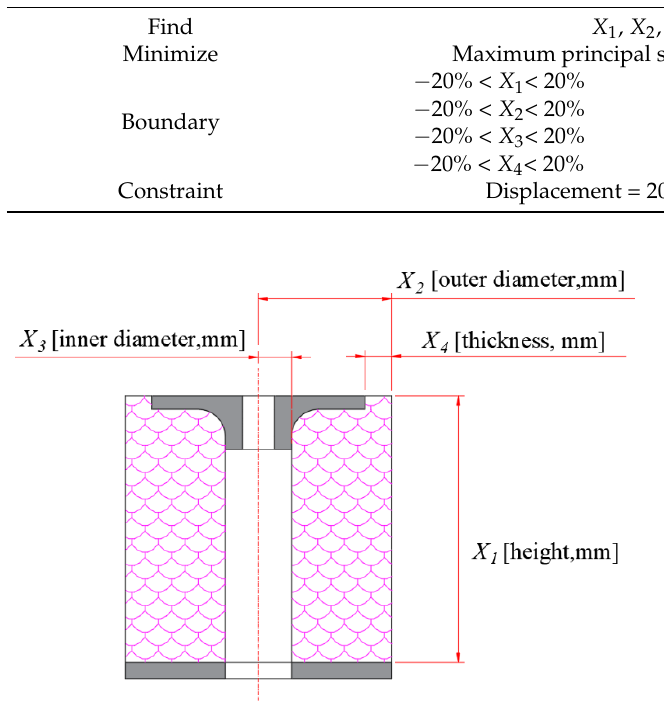
Figure 11. Design parameters for polyurethane spring.